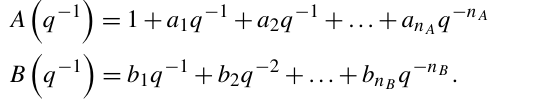
Figure 2. The principle of the 3D EVC.